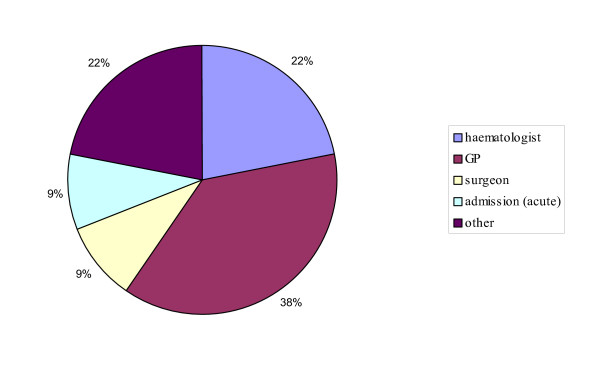
Source of referral.